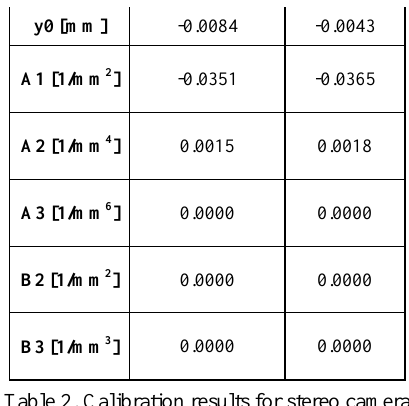
Table 2. Calibration results for stereo camera